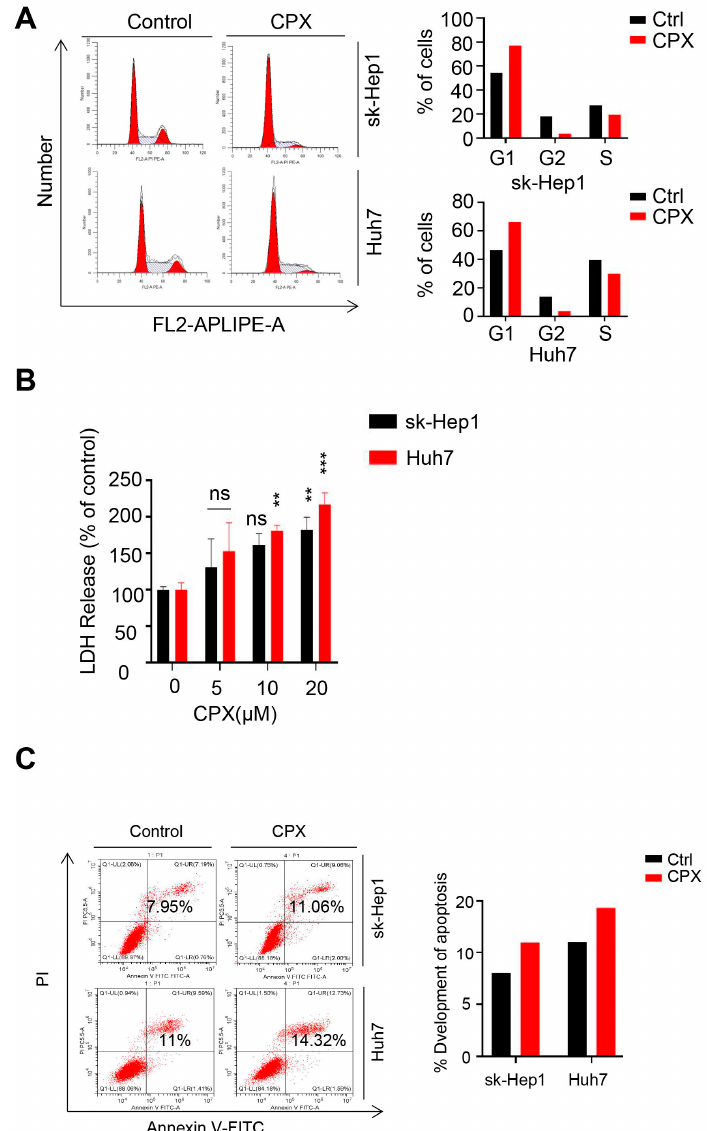
Figure 2. CPX hinders the cell cycle progression of HCC cells. ( A ). sk-Hep1 and Huh7 cells treated with or without 20 µ M CPX for 24 h were subjected to flow cytometry analysis of the cell cycle distribution. ( B ) The release of dehydrogenase (LDH) in sk-Hep1 and Huh7 cells treated with indicated concentrations of CPX for 24 h was measured. ( C ) sk-Hep1 and Huh7 cells treated with or without 20 μ M CPX for 24 h were stained with Annexin V/PI, and then detected by flow cytometry. The apoptosis rate was quantitated. Data are means ± s.d. and are representative of 3 independent experiments. **, p < 0.01, ***, p < 0.001. Statistical significance compared with respective control groups.